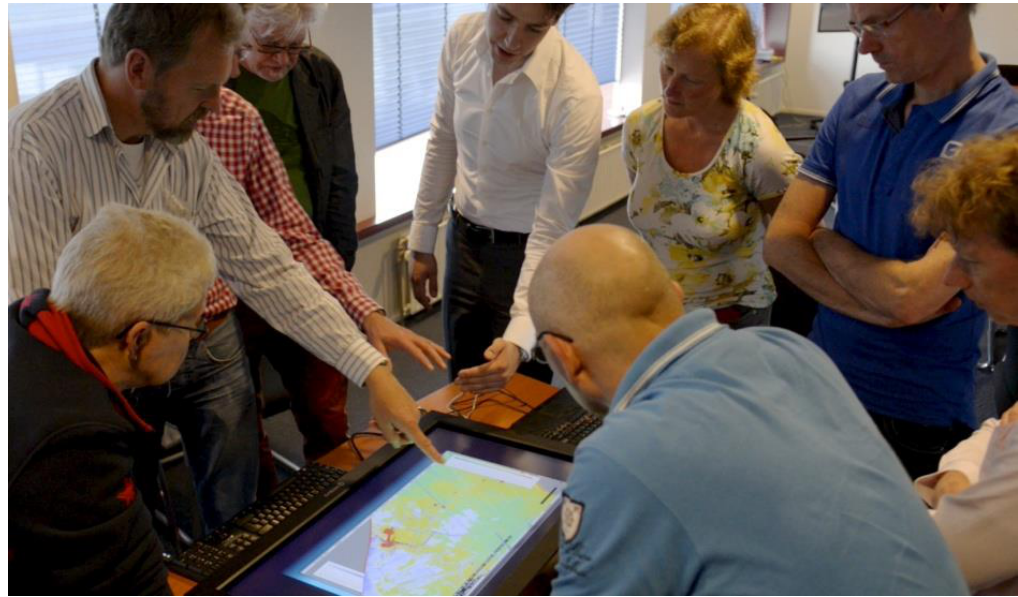
Figure 1. Use of the Interactive Water Simulation Model for the workshop ‘Watergraafsmeer’ [23].